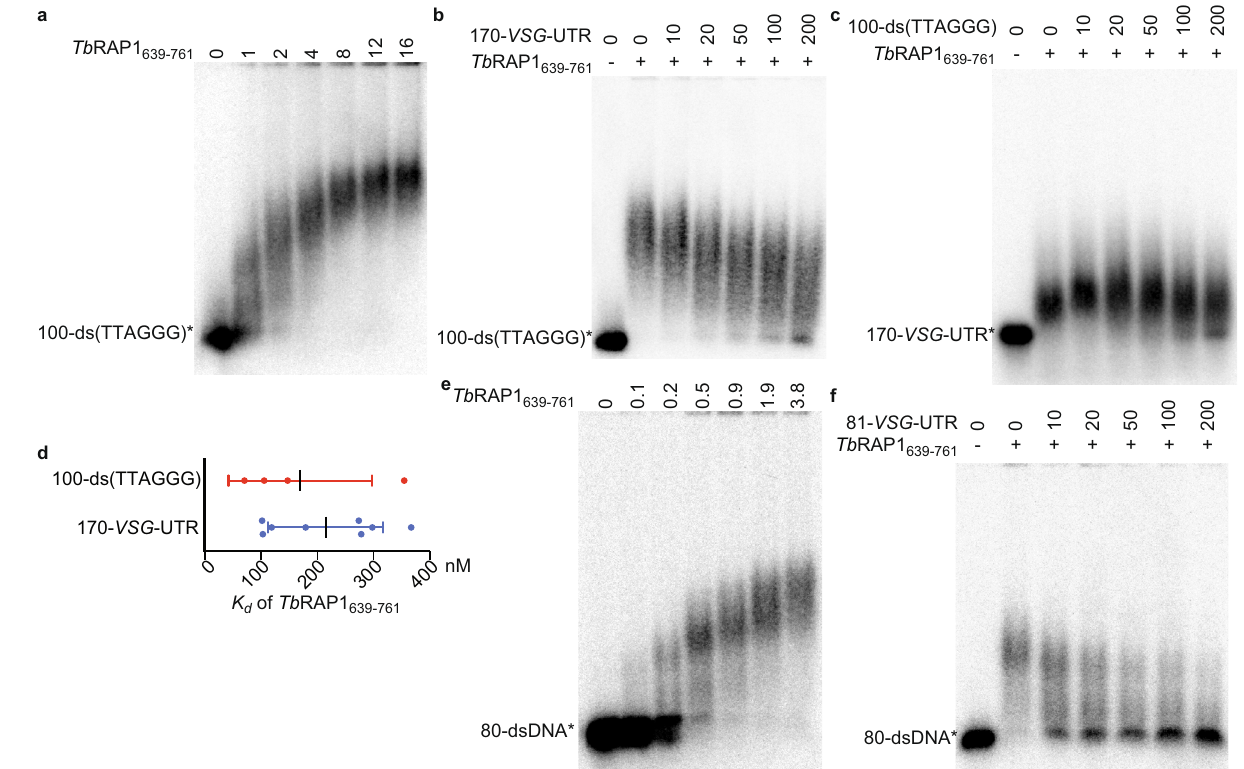
Fig. 7 | Tb RAP1 ’ s RNA and DNA binding activities compete with each other. EMSA experiments were performed using Tb RAP1 639 – 761 . Radiolabeled 100- ds(TTAGGG)( a , b ),170- VSG -UTR( c ),and 80-dsDNA ( e , f ) wereused asthe binding substrates. Non-radiolabeled 170- VSG -UTR ( b ), 100-ds(TTAGGG) ( c ), and 81- VSG - UTR( f )wereusedascompetitors.Theconcentrationof proteins( µ M)used ineach experiment is indicated on top of each lane in ( a ) and ( e ). 4.7 µ M ( b ), 2.35 µ M ( c ), and 0.5 µ M ( f ) of Tb RAP1 639 – 761 was used in each competition reaction. The molar